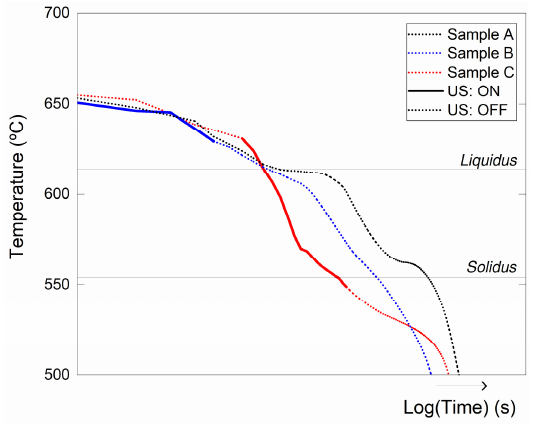
Figure 3. Temperature–time for each experimental condition. The active regime of the acoustic energy supplied by the US is denoted by a thicker/wider line.